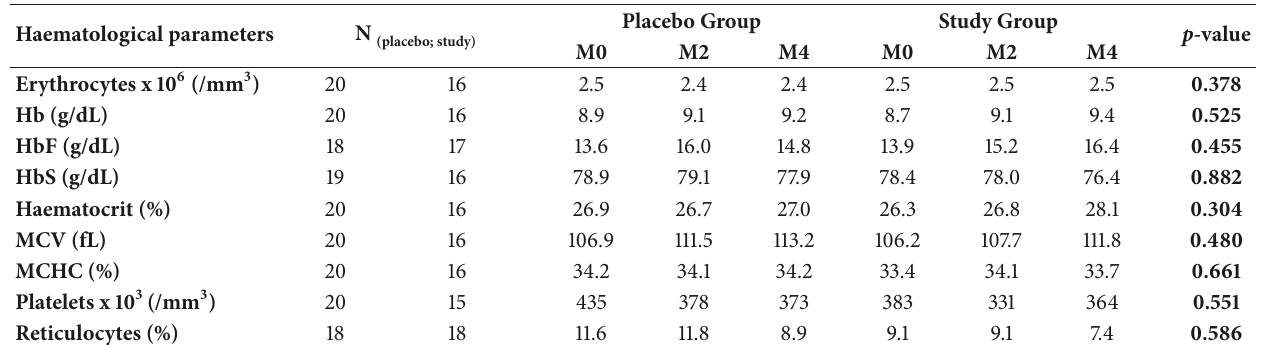
Table 2: Haematological parameters of patients with SCA during the trial.